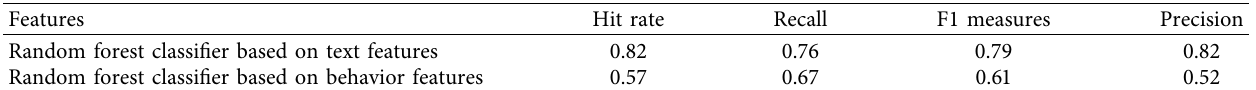
Table 3: Performance comparison results of the two types of features in a single